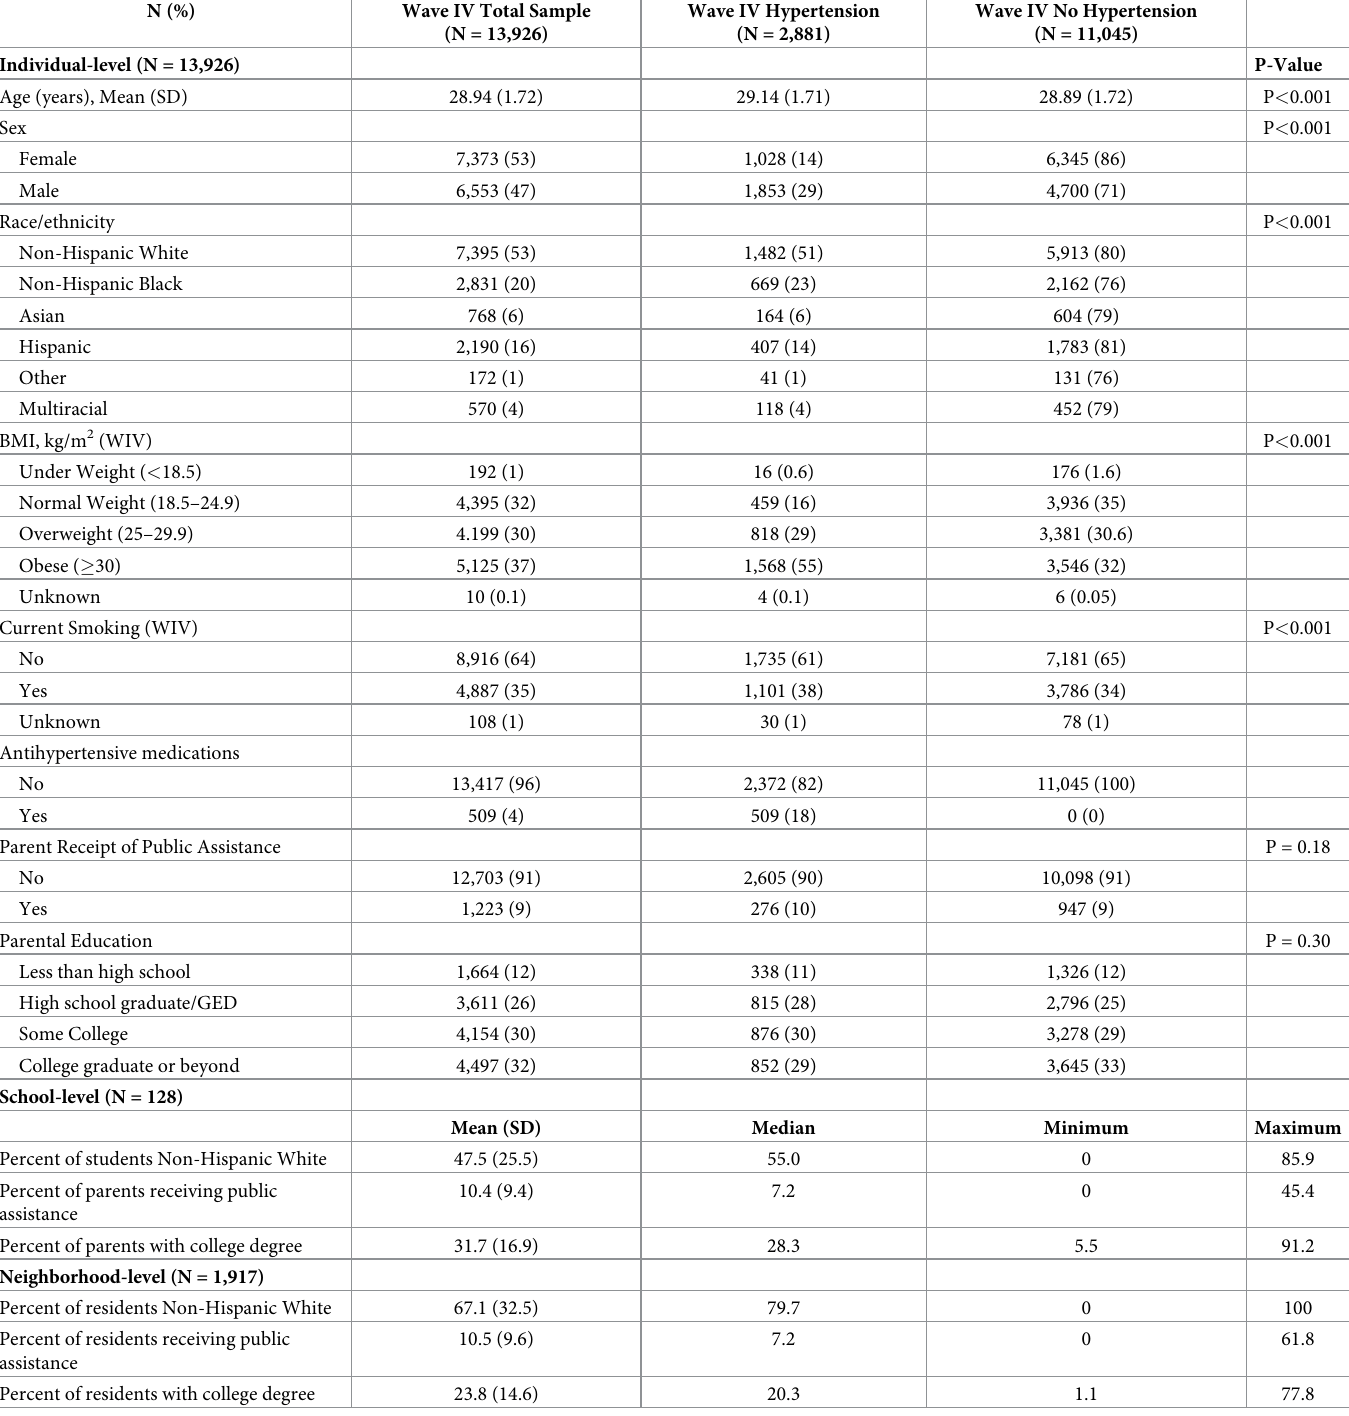
Table 1. Individual-, school-, and neighborhood-level Wave I (1994–1995) characteristics of participants in young adulthood at Wave IV (2008–2009; N = 13,926) of the National Longitudinal Study of Adolescent to Adult